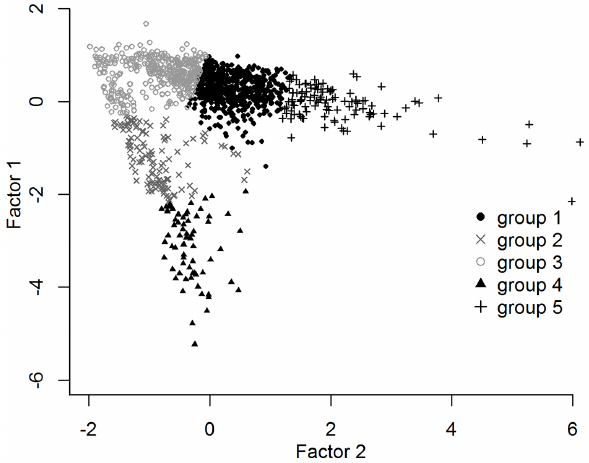
Figure 3. Classification of the PDER events ( n =1268) by the K- means cluster analysis. The number of groups was set to k =5 and the temperature variables’ means from each group from the complete- linkage hierarchical clustering procedure were used as initial seeds. When compared to the preliminary visual classification, groups 1, 3 and 5 mostly contained PDER events deemed milk ingestions, while groups 2 and 4 were mainly composed of PDER events deemed seawater or solid food